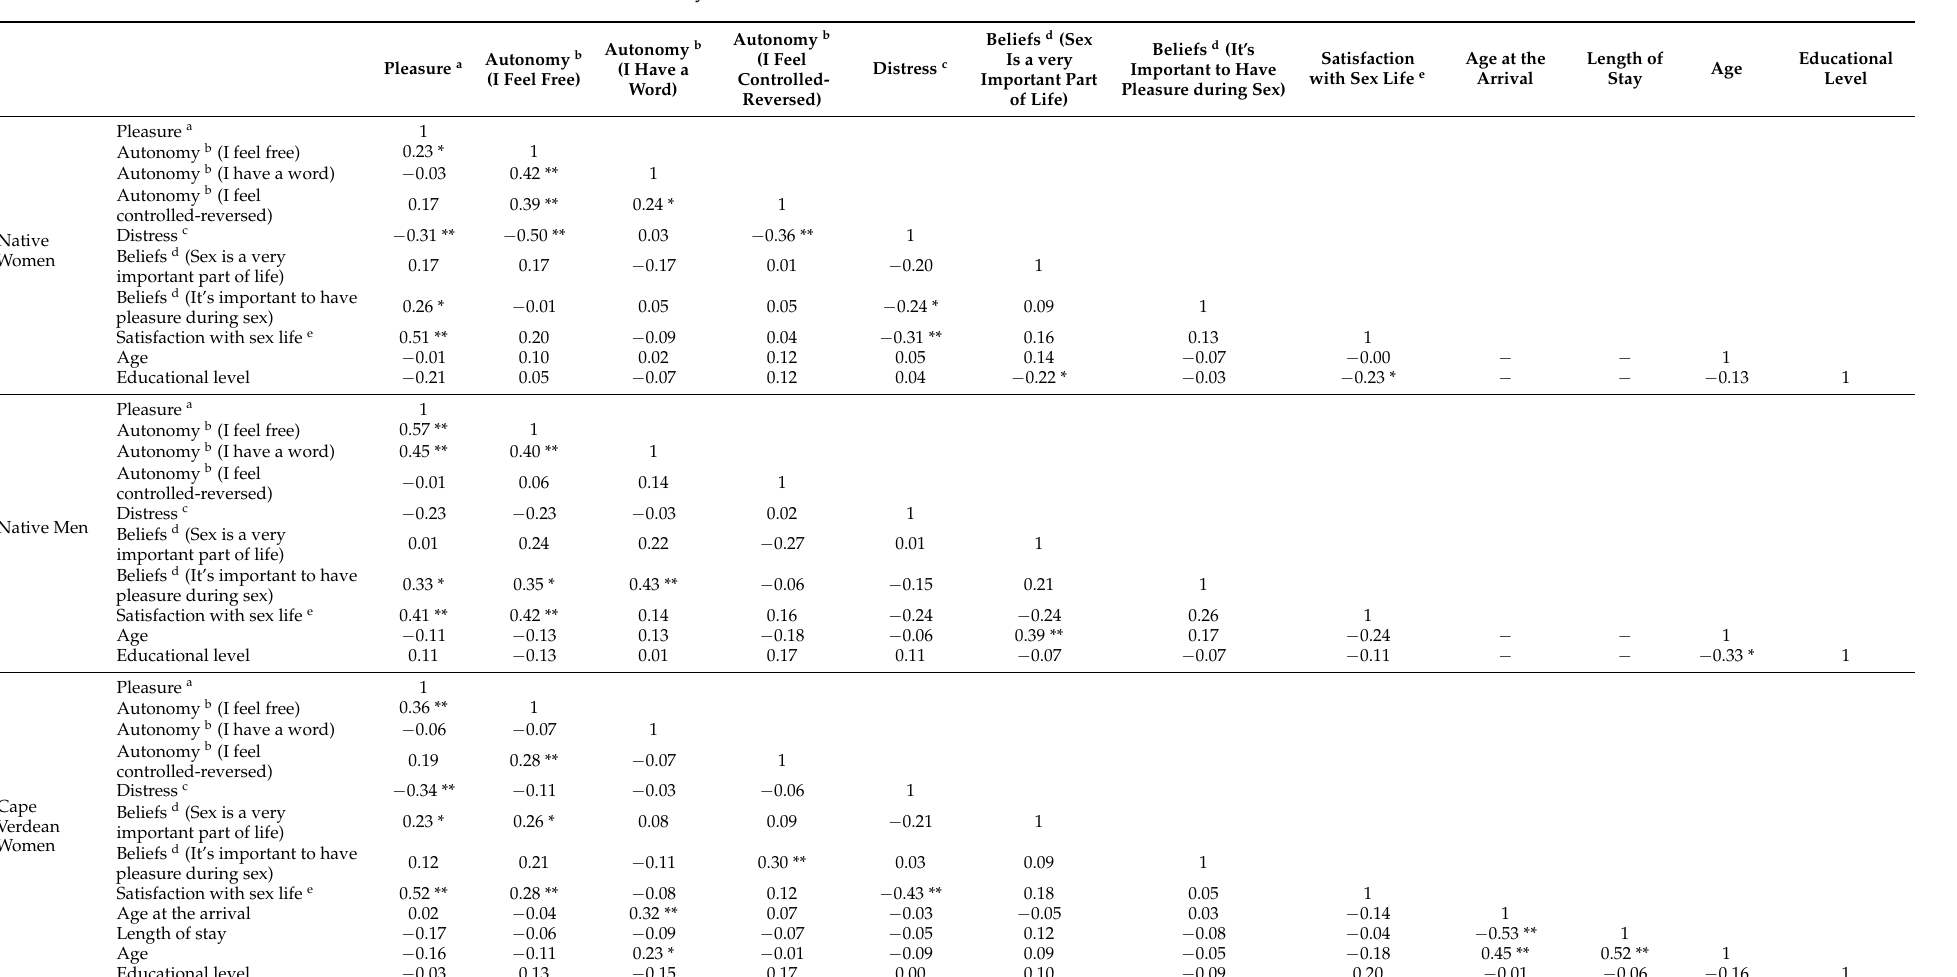
Table 3. Correlations between sexuality-related variables, social and acculturation-related measures.